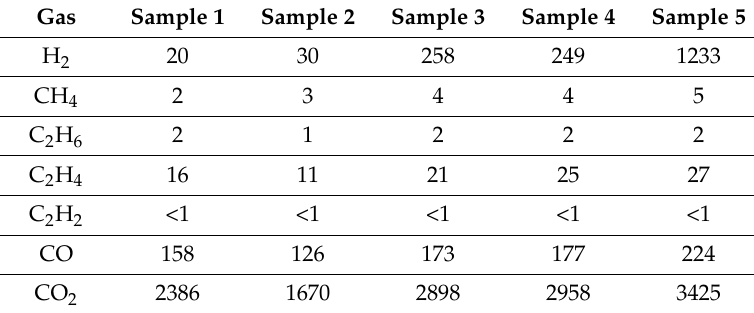
Table 8. DGA history of transformer